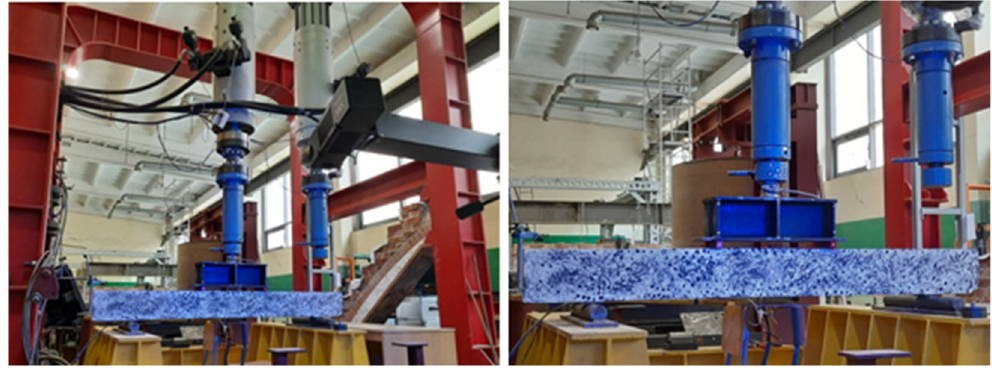
Figure 4. Test stand. Sample prepared for optical measurements of